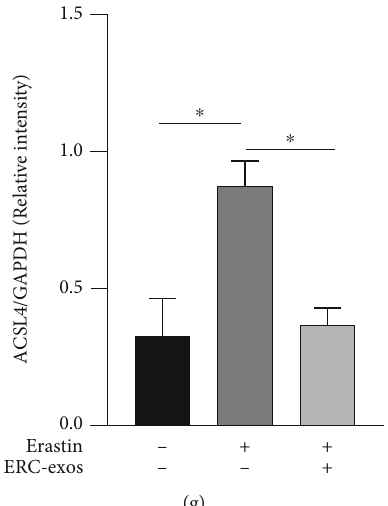
Figure 3: ERC-exos downregulated ferroptosis induced by erastin in NCM460. (a) Relative vitality in erastin-induced NCM460 was measured by CCK-8 kit. The levels of (b) iron, (c) GSH, and (d) MDA in NCM460 treated with erastin or ERC-exos. (e – g) The GPX4 and ACSL4 protein expressions in NCM460 measured by western blot. The p value was calculated by one-way ANOVA. ∗ p < 0 : 05 , ∗∗ p < 0 : 01 , ∗∗∗ p < 0 : 001 , and ∗∗∗∗ p < 0 : 0001